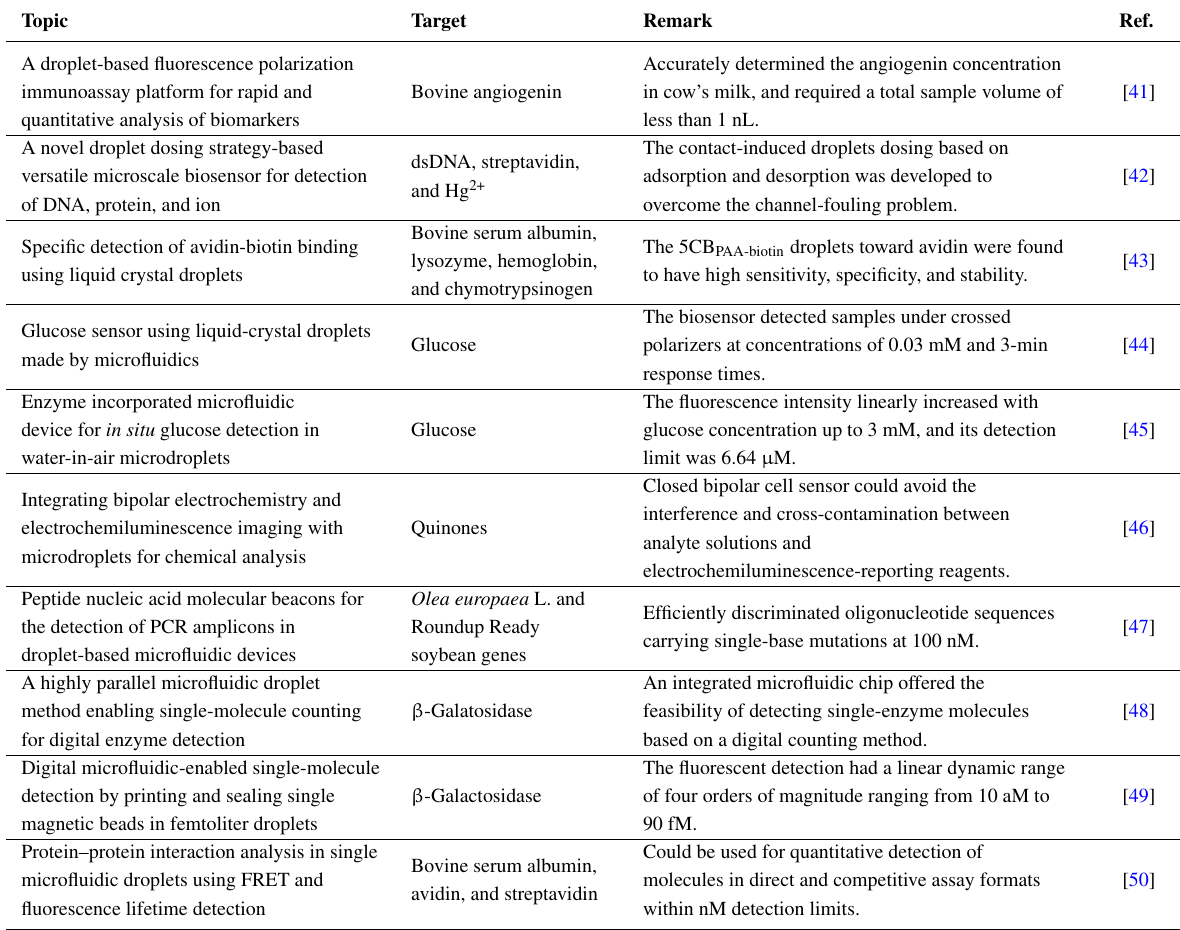
Table 1. Recent applications of droplet microfluidics in molecular